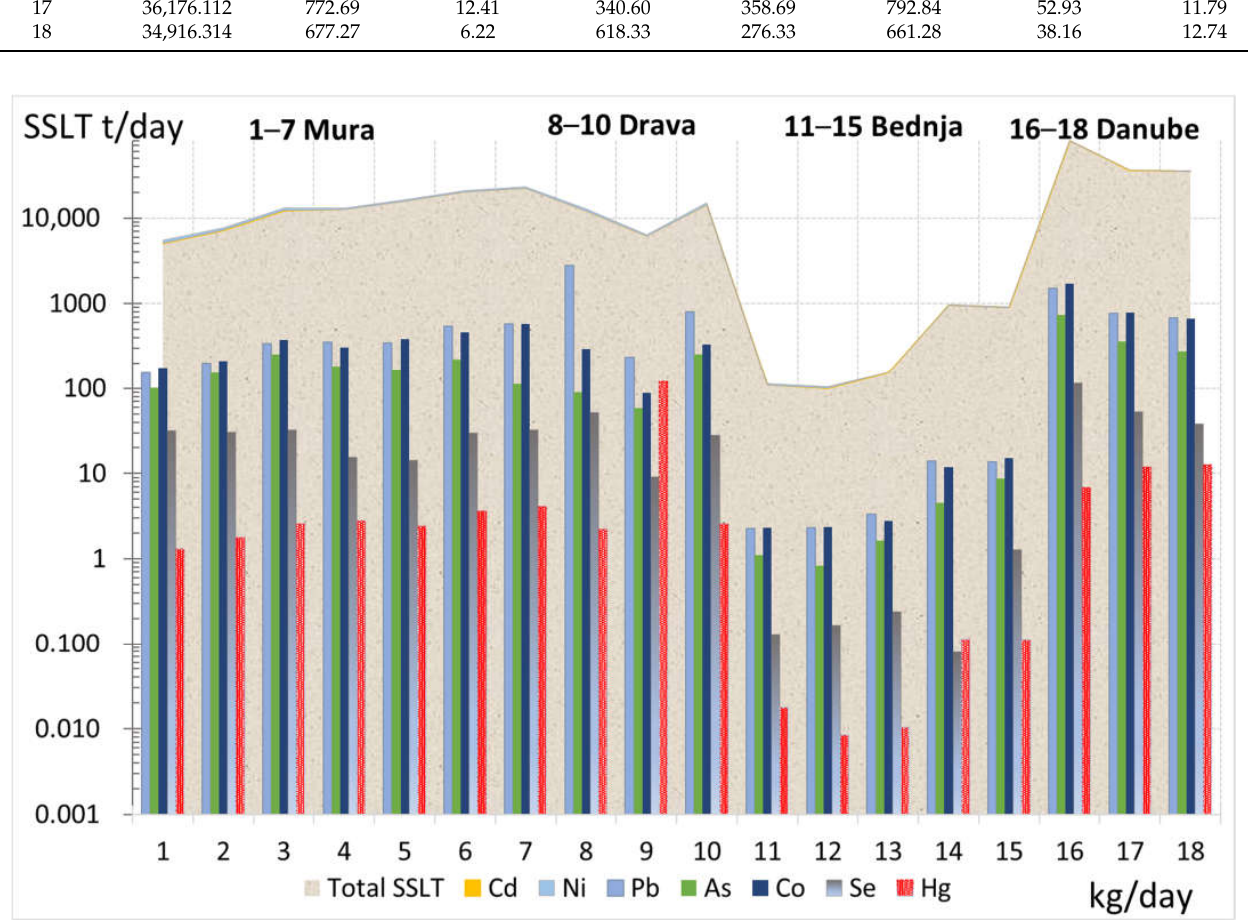
Figure 7. The total amount of metals (kg/day) in daily